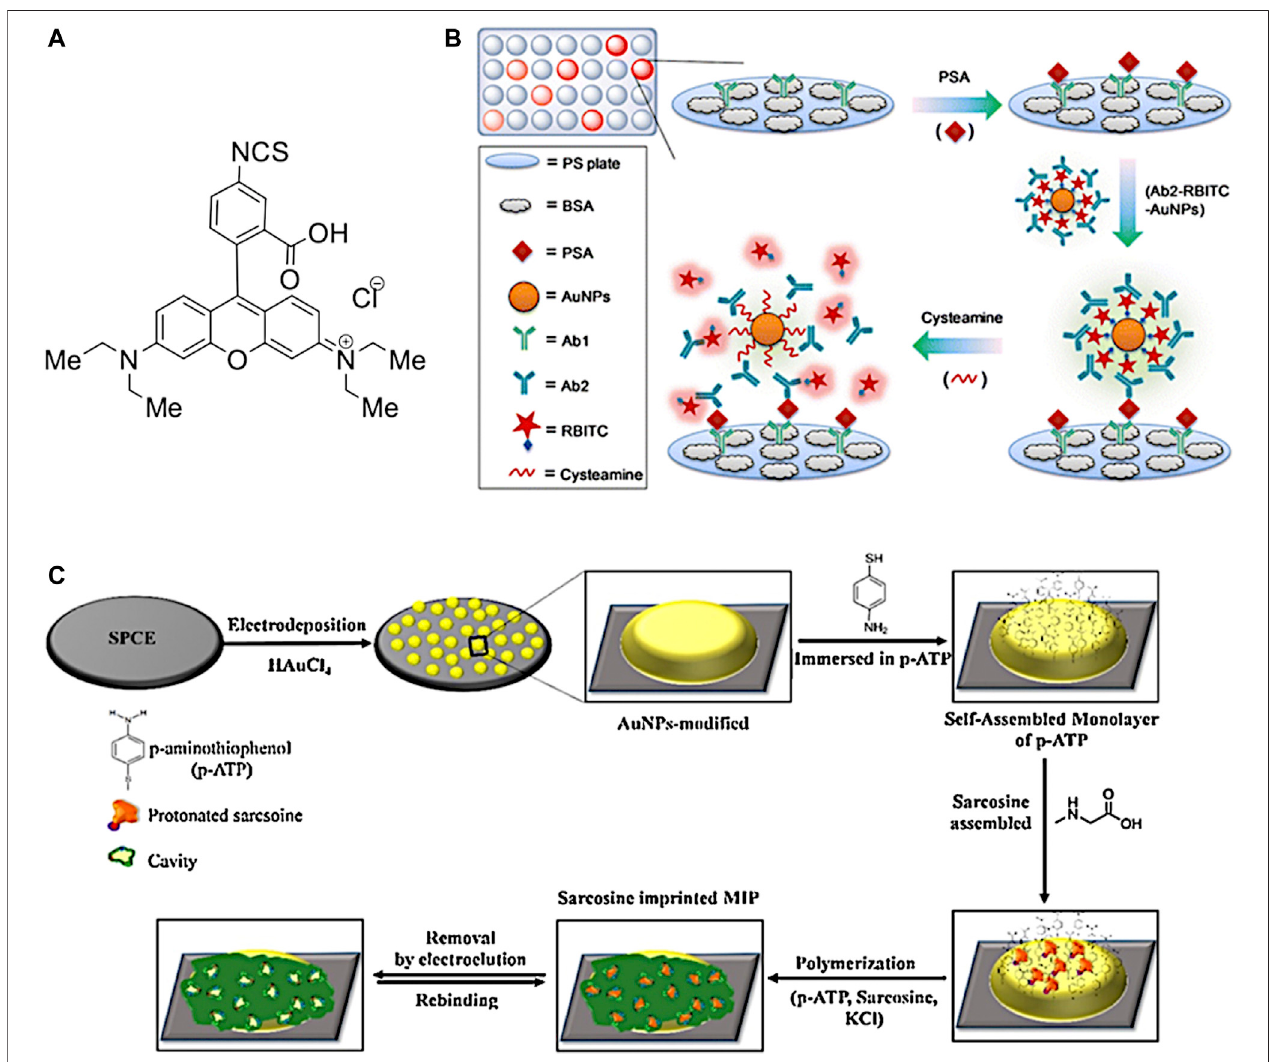
FIGURE 12 | (A) Example of a fl uorescent dye (denoted RBITC) used in the synthesis of the fl uorescence-activated probe Ab2-RBITC-AuNP, (B) procedure as demonstrated by D. Liu et al. for the synthesis of the AuNP activated probe for early PSA detection ( fi gure adapted from Ref (Liu et al., 2013)) (C) an overview of the procedure in described for the formation of MIP/AuNPs/SPCE ( fi gure adapted from (Nguy et al., 2017)).